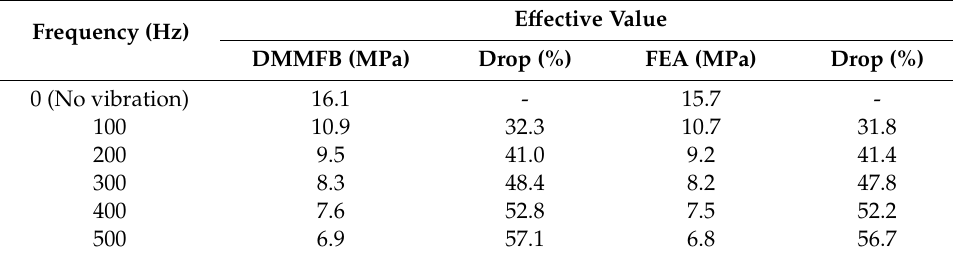
E ff ective value of the pressure drop without and with 0.35 g vibration applied at di ff erent frequencies.